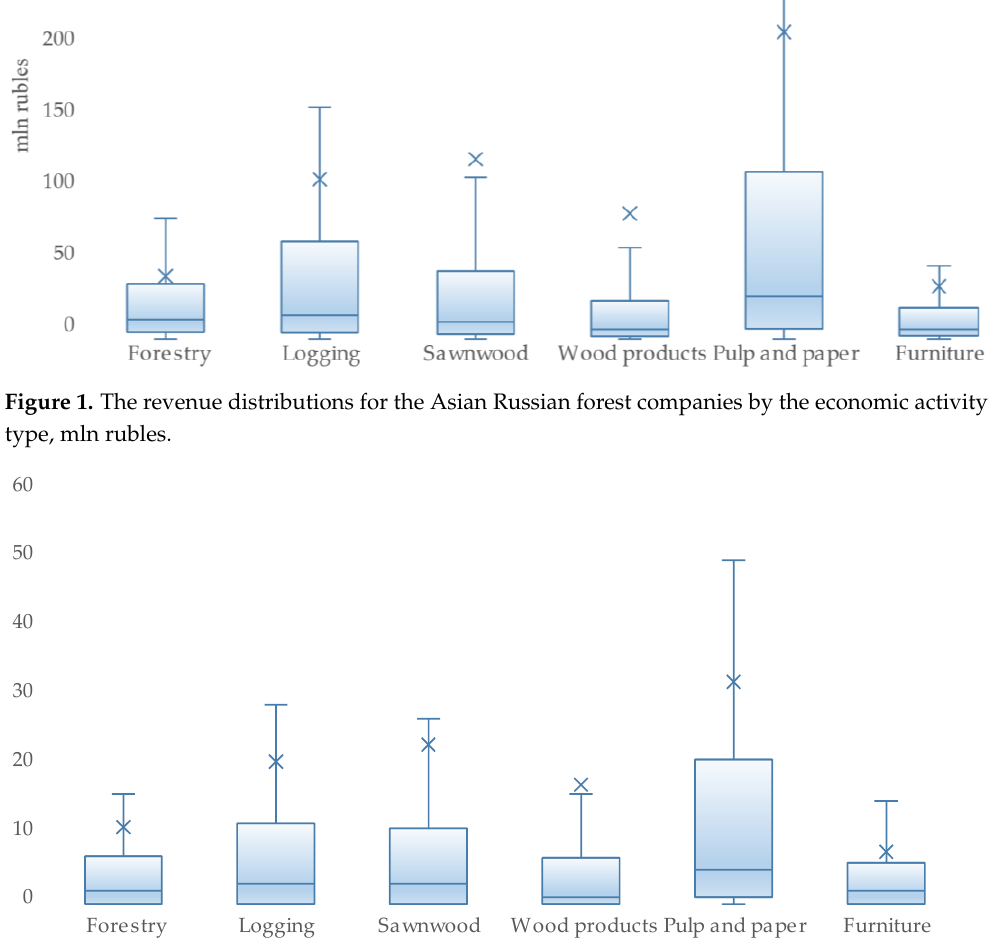
Figure 2. The number of employees distributions for the Asian Russian forest companies by the economic activity type.